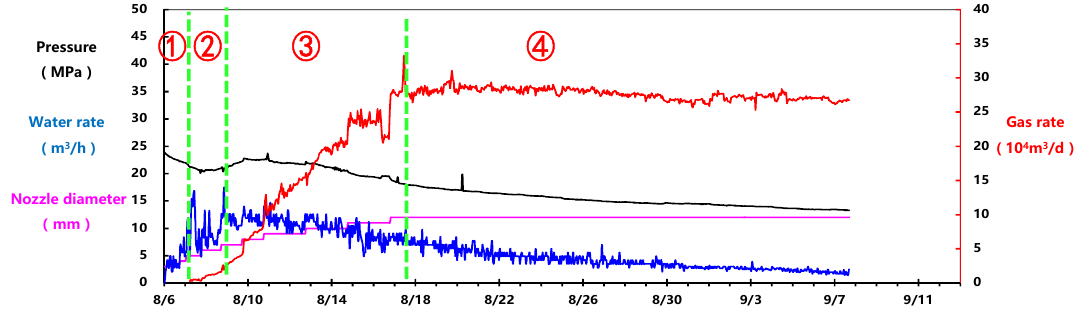
Figure 8. Flowback characteristic curve of shale gas wells.